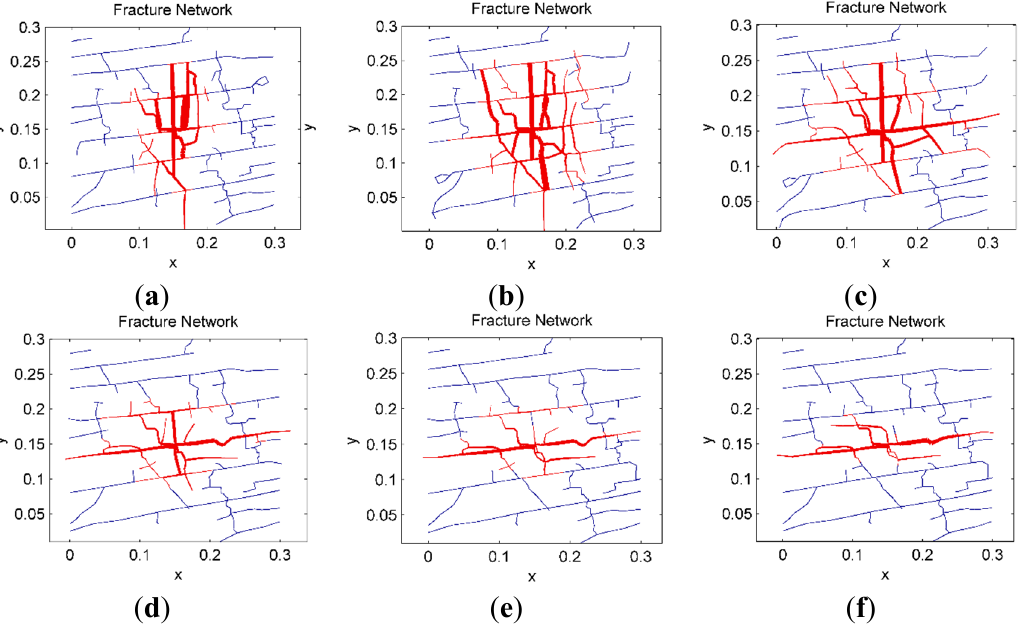
(cid:3398) σ (cid:3404) (cid:3398)10 MPa , (cid:1845)(cid:1827) (cid:3404) (cid:3398)3.3 ; (cid:3051) (cid:3052) (cid:3051)(cid:3052) (cid:3398) σ (cid:3404) (cid:3398)2 MPa , (cid:1845)(cid:1827) (cid:3404) (cid:3398)0.66 ; (cid:3051) (cid:3052) (cid:3051)(cid:3052) (cid:3398) σ (cid:3404) 6 MPa , (cid:1845)(cid:1827) (cid:3404) 2.0 ; ( f ) σ (cid:3398) σ (cid:3404) (cid:3051) (cid:3052) (cid:3051)(cid:3052) (cid:3051) (cid:3052)